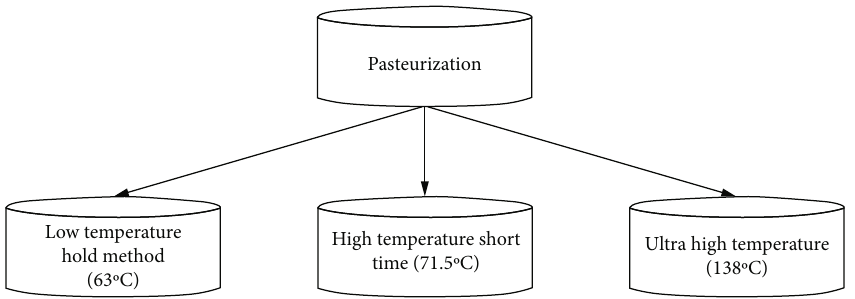
Figure 3: Pasteurization process in di ff erent temperature.